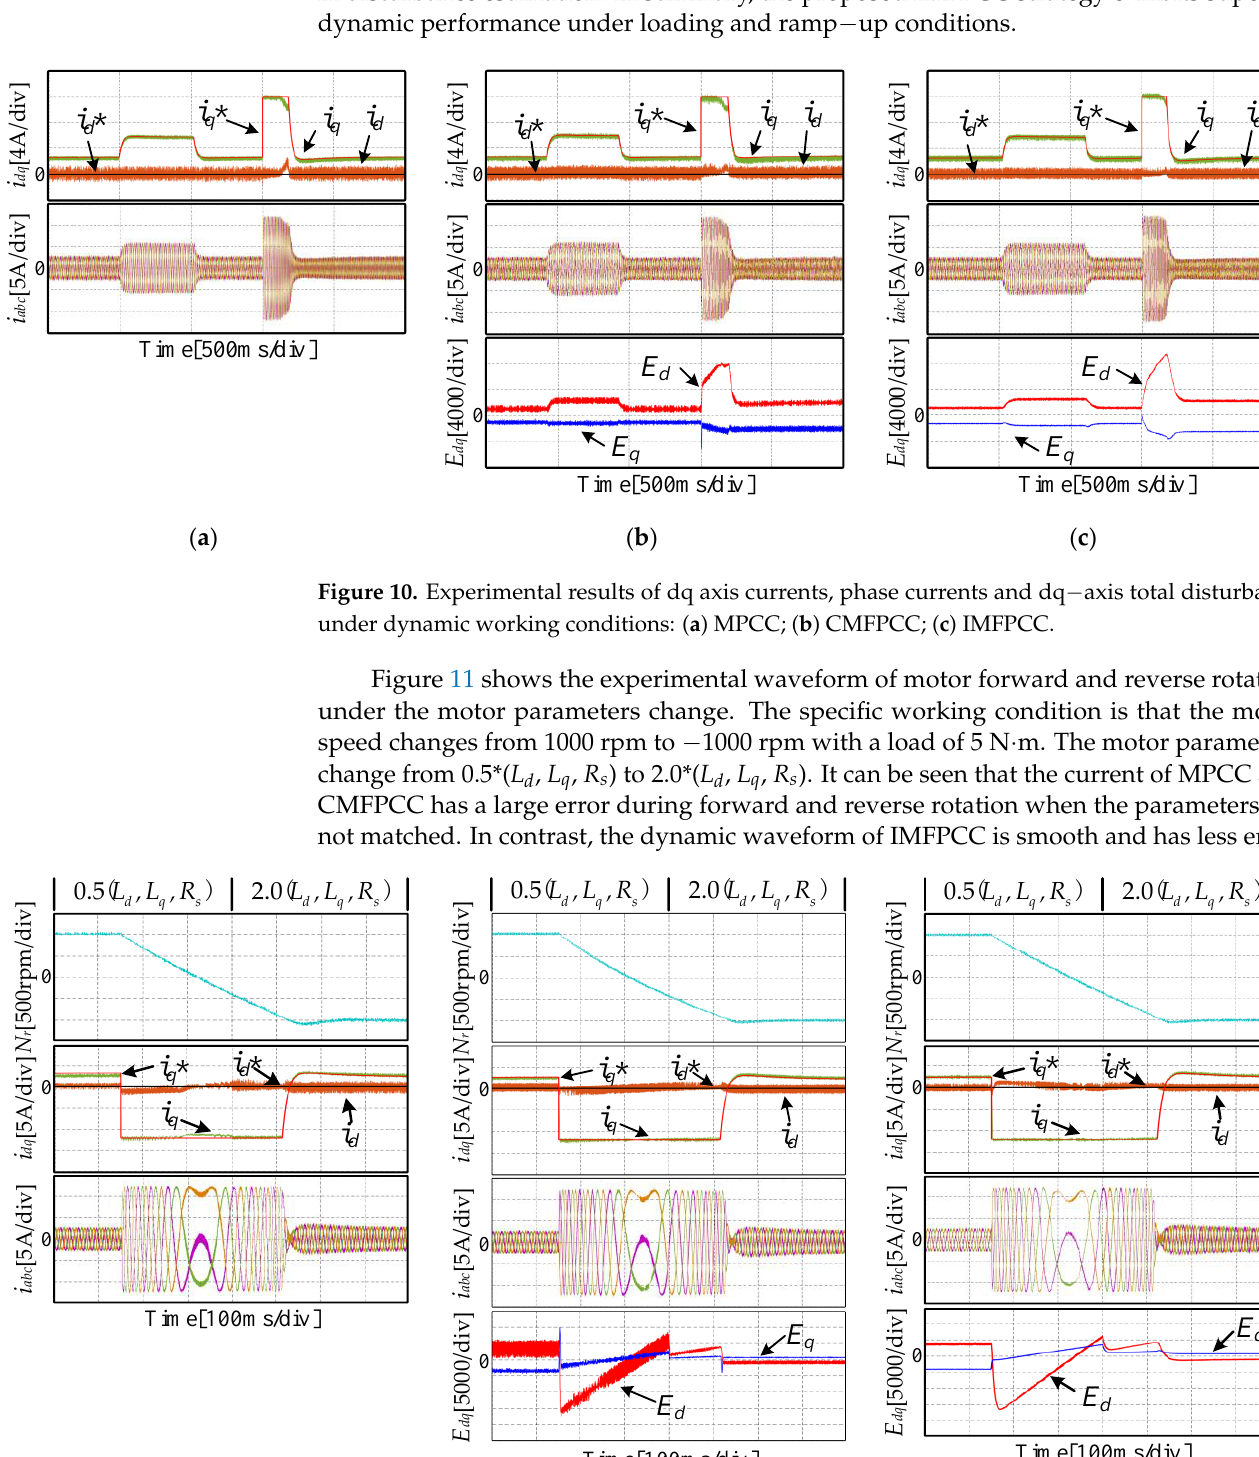
Figure 11. Experimental results of forward and reverse rotation under the change of motor parameters: ( a ) MPCC; ( b ) CMFPCC; ( c ) IMFPCC.